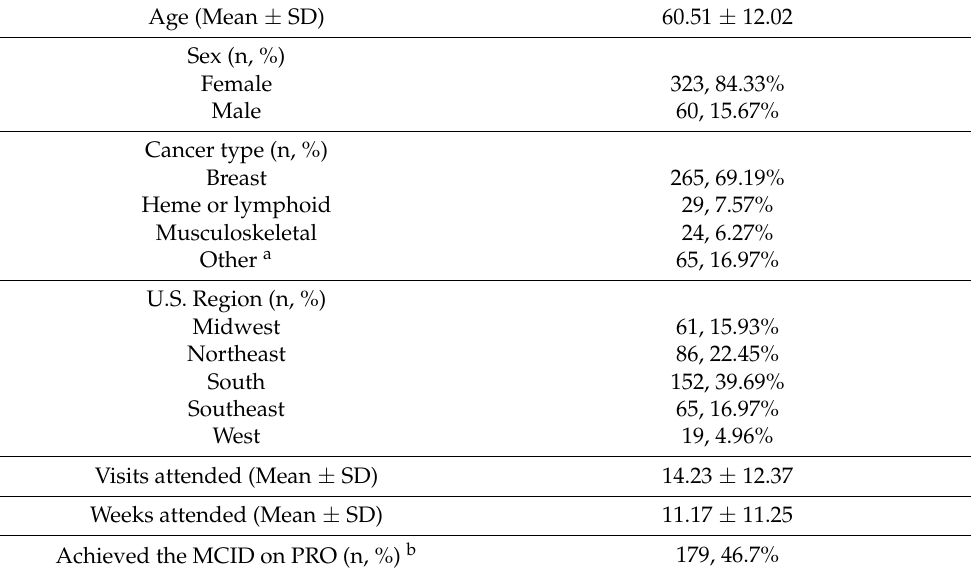
Table 1. Patients who attended cancer physical or occupational therapy (PT/OT), n =